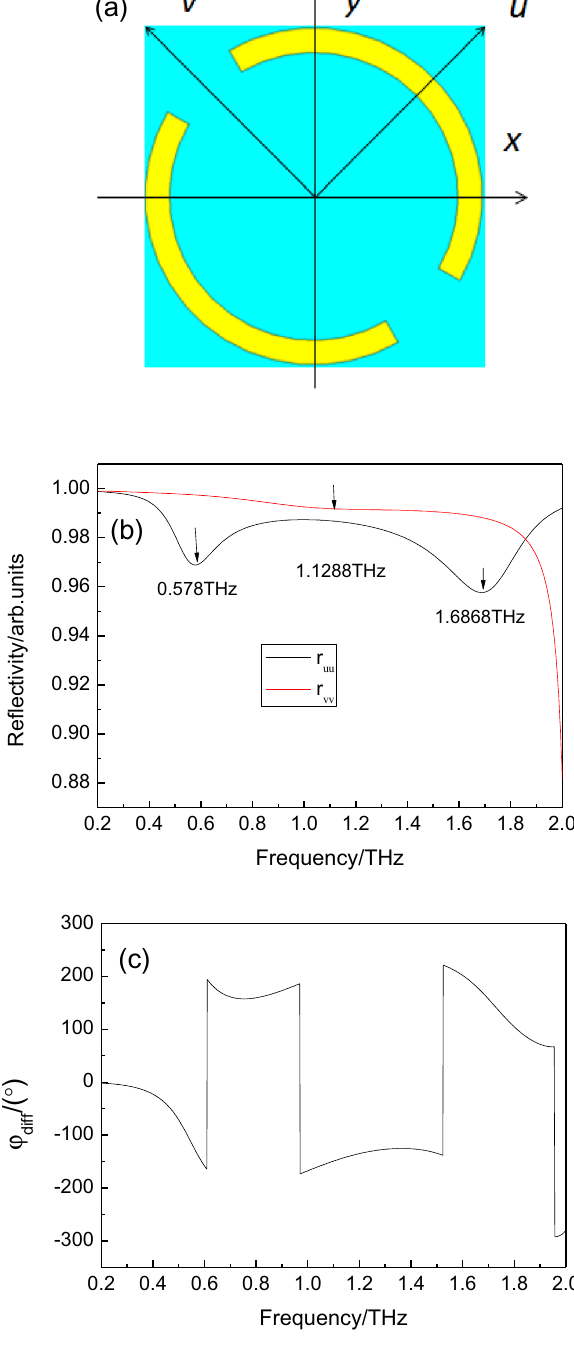
Fig. 4 a Definition of u and v axes; b Reflectivity of co-polarization; c Phase difference of